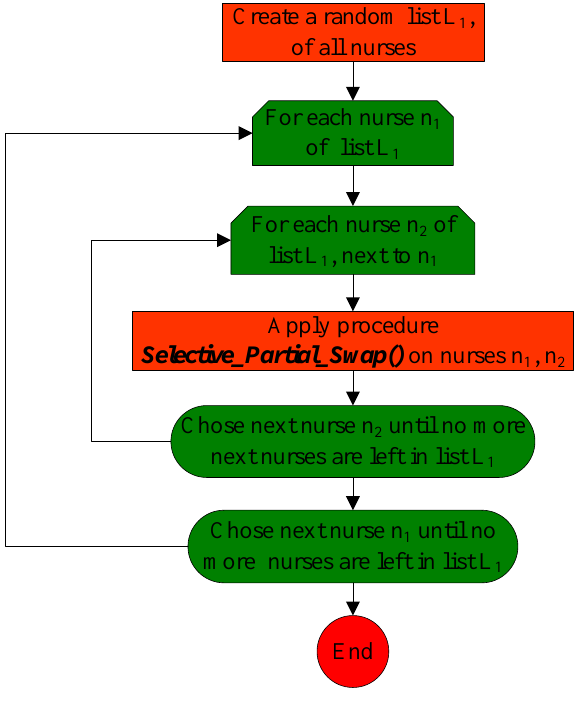
Figure 3. The structure of the procedure, Successive _ Segment_Swap_Mutation